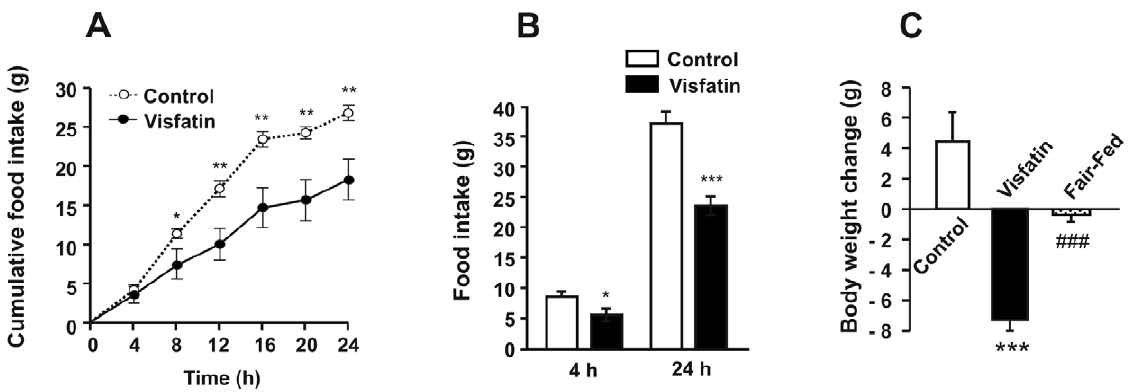
Figure 1. Effects of ICV administration of visfatin on food intake and body weight. Food intake and body weight were measured in rats that had received an ICV injection of visfatin. (A) Cumulative food intake was measured for one day at 4 h intervals after an ICV injection of visfatin. Control animals received a 0.9% saline solution. (B) Effect of visfatin on food intake in rats showing strong appetites induced by food deprivation for one day. (C) Effect of visfatin on body weight changes one day after ICV injection. Data are represented as mean 6 SEM (n=10). *P , 0.05, **P , 0.01 and ***P , 0.001 vs. control rats; ### P , 0.001 vs. visfatin-injected rats.